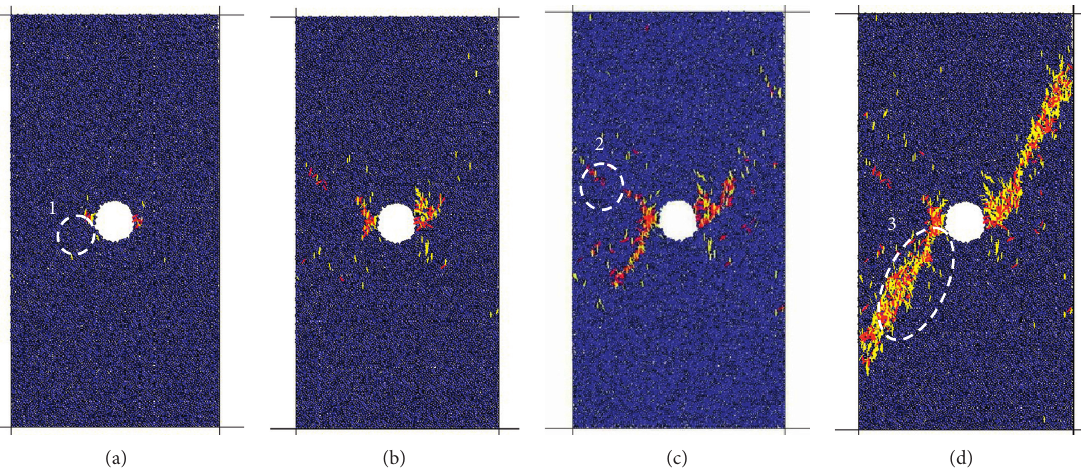
Figure 9: Space-time evolution process of microcracks during loading: (a) 85,000 step before peak, (b) 94,120 step at peak, (c) 100,000 step after peak, and (d) 109,120 step after peak. 1: notch fractures; 2: far-field fractures; 3: shear damage.